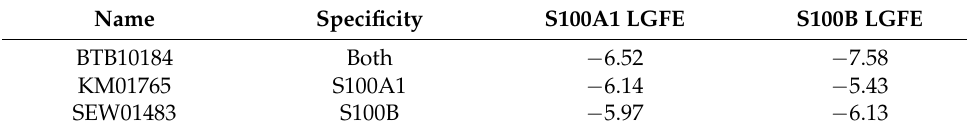
Table 1. LGFEs for predicted binding poses of compounds for S100A1 and S100B.